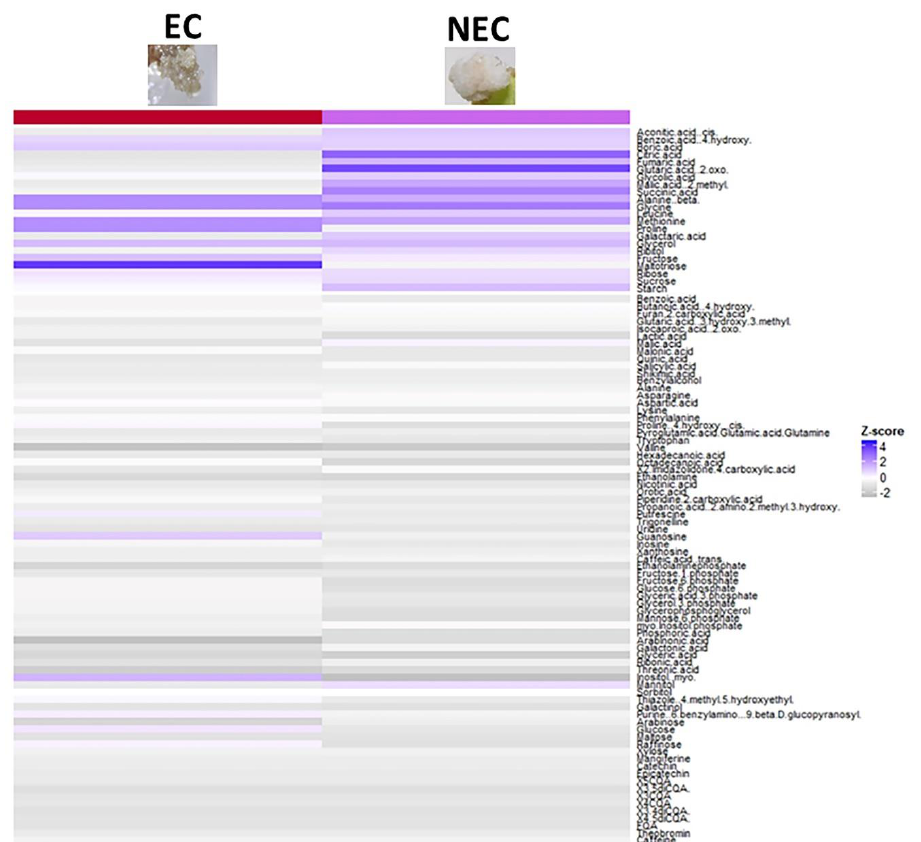
Figure 6. Profiling primary and secondary metabolites in embryogenic (EC) and non-embryogenic calli (NEC). Heatmap generated from the Z-score values of a total of 92 primary metabolites and 12 secondary metabolite detected. Rows correspond to metabolites and columns to the type of callus. Positive Z-score values are shown in blue and negative values in grey.